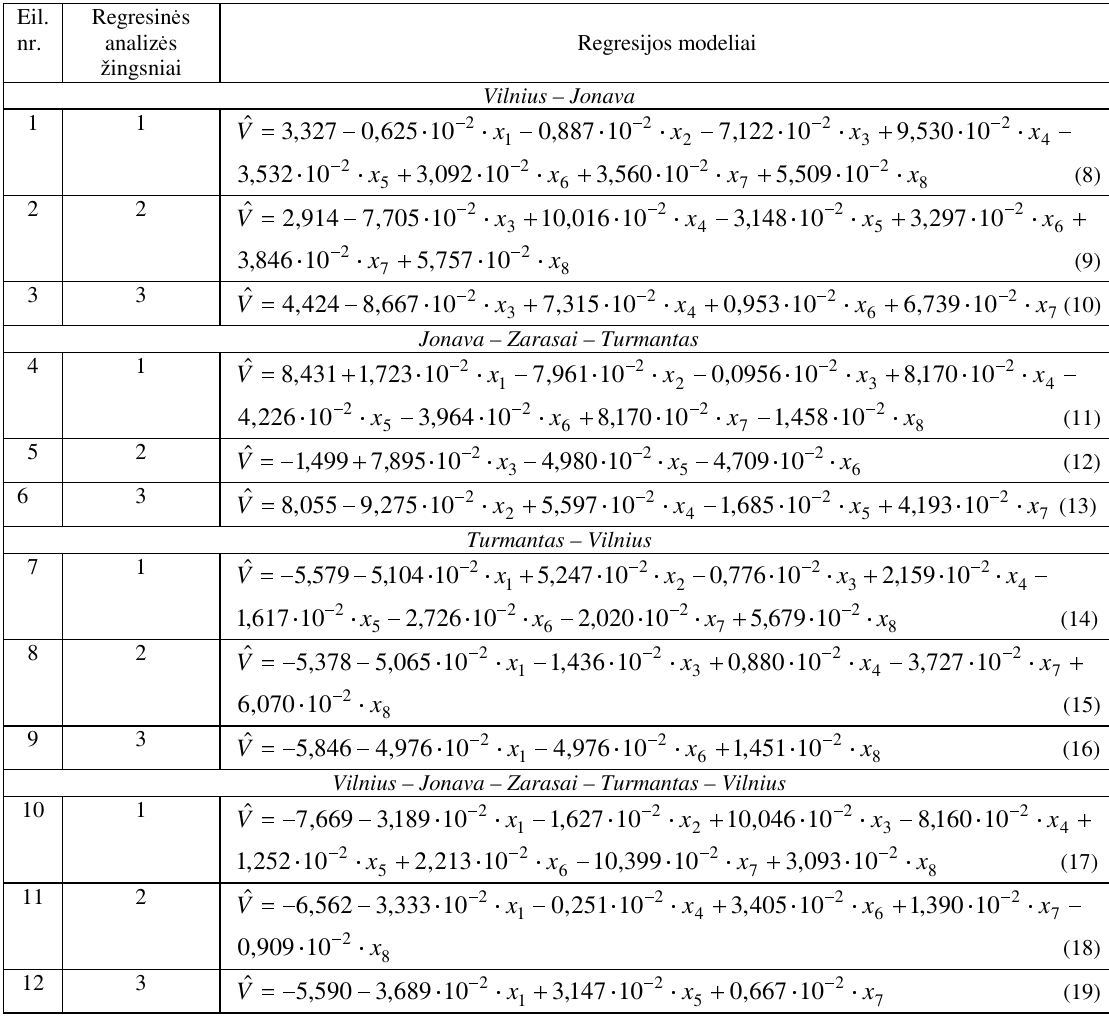
Table 3. Regression